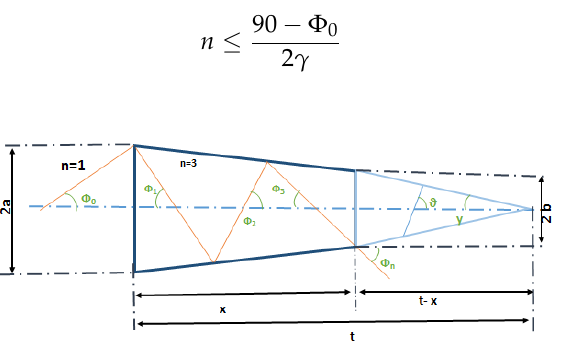
Figure 24. Conical concentrator with its parameters as proposed by Schmidt-Kloiber et al.